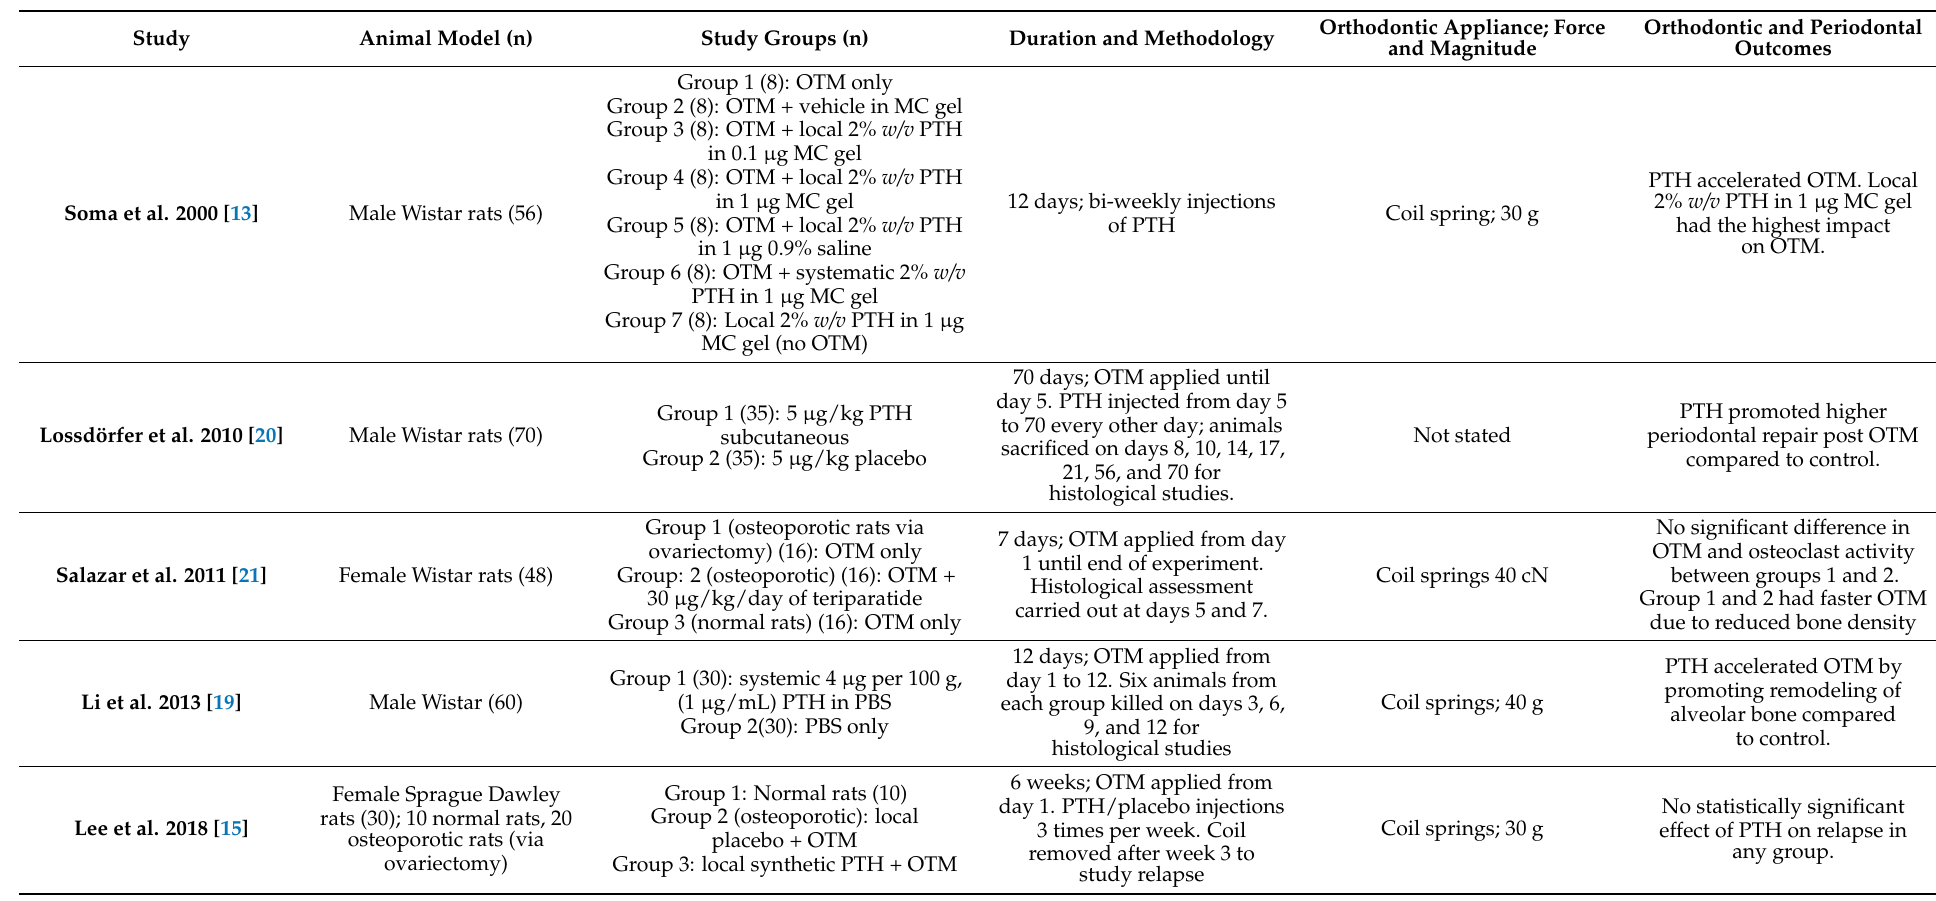
Table 1. General characteristics and outcomes of studies included in this review. PTH: parathyroid hormone; OTM: orthodontic tooth movement; PD: periodontal